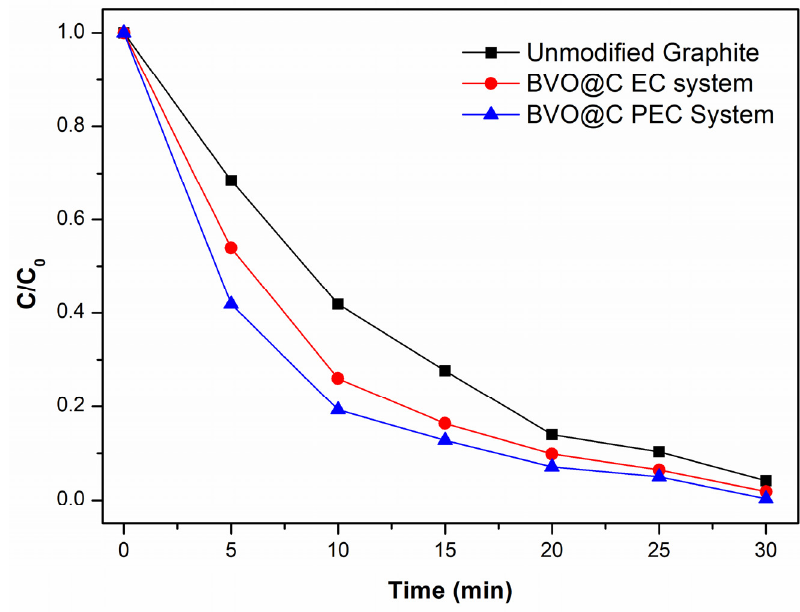
Figure 9. Degradation of pollutants during photoelectrocatalysis (PEC) and electrocatalysis (EC). Initial RhB concentration of 20 mg L − 1 , using NaCl as electrolytic support (0.05 mol L − 1 ), pH of natural solution, at room temperature.